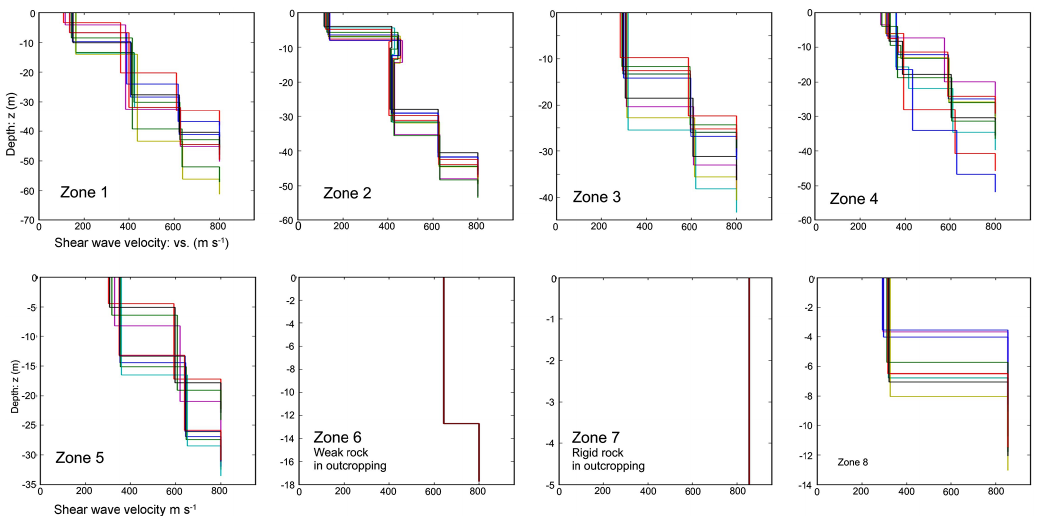
Figure 4. V S – h trainer models: there are 10 trainer models theoretically encountered in each of the eight zones, which are presented in the SRS (Fig.